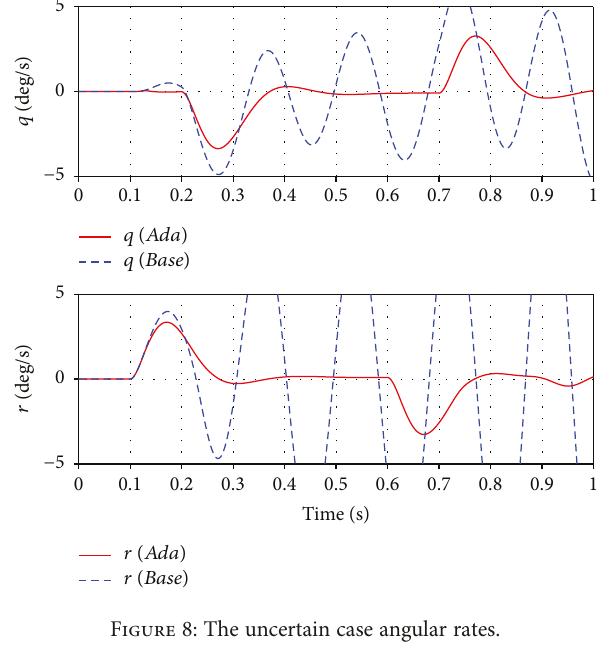
Figure 8: The uncertain case angular rates.